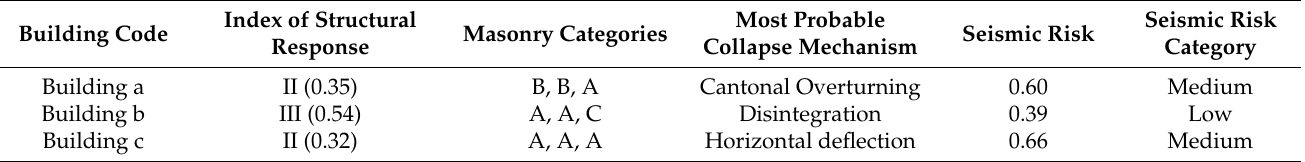
Table 8. Result of the evaluation of buildings in